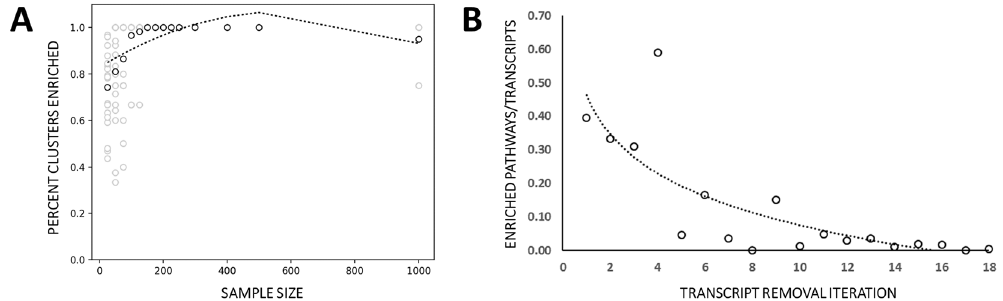
Figure 6. Cluster Coherence Increases with Sample Size and Functional Enrichment Decreases with Decreasing DQC Feature Selection Threshold. ( A ) Percent of clusters enriched for at least one tumor type increases with sample size; ( B ) The number of Reactome pathways at each level of feature selection corrected for transcript